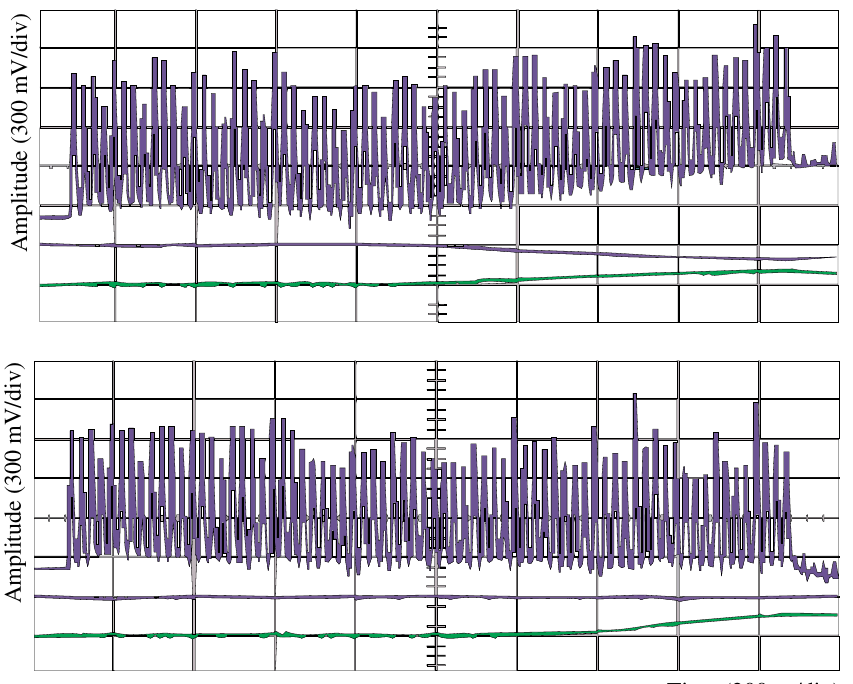
(cid:5) 0 (upper solenoid